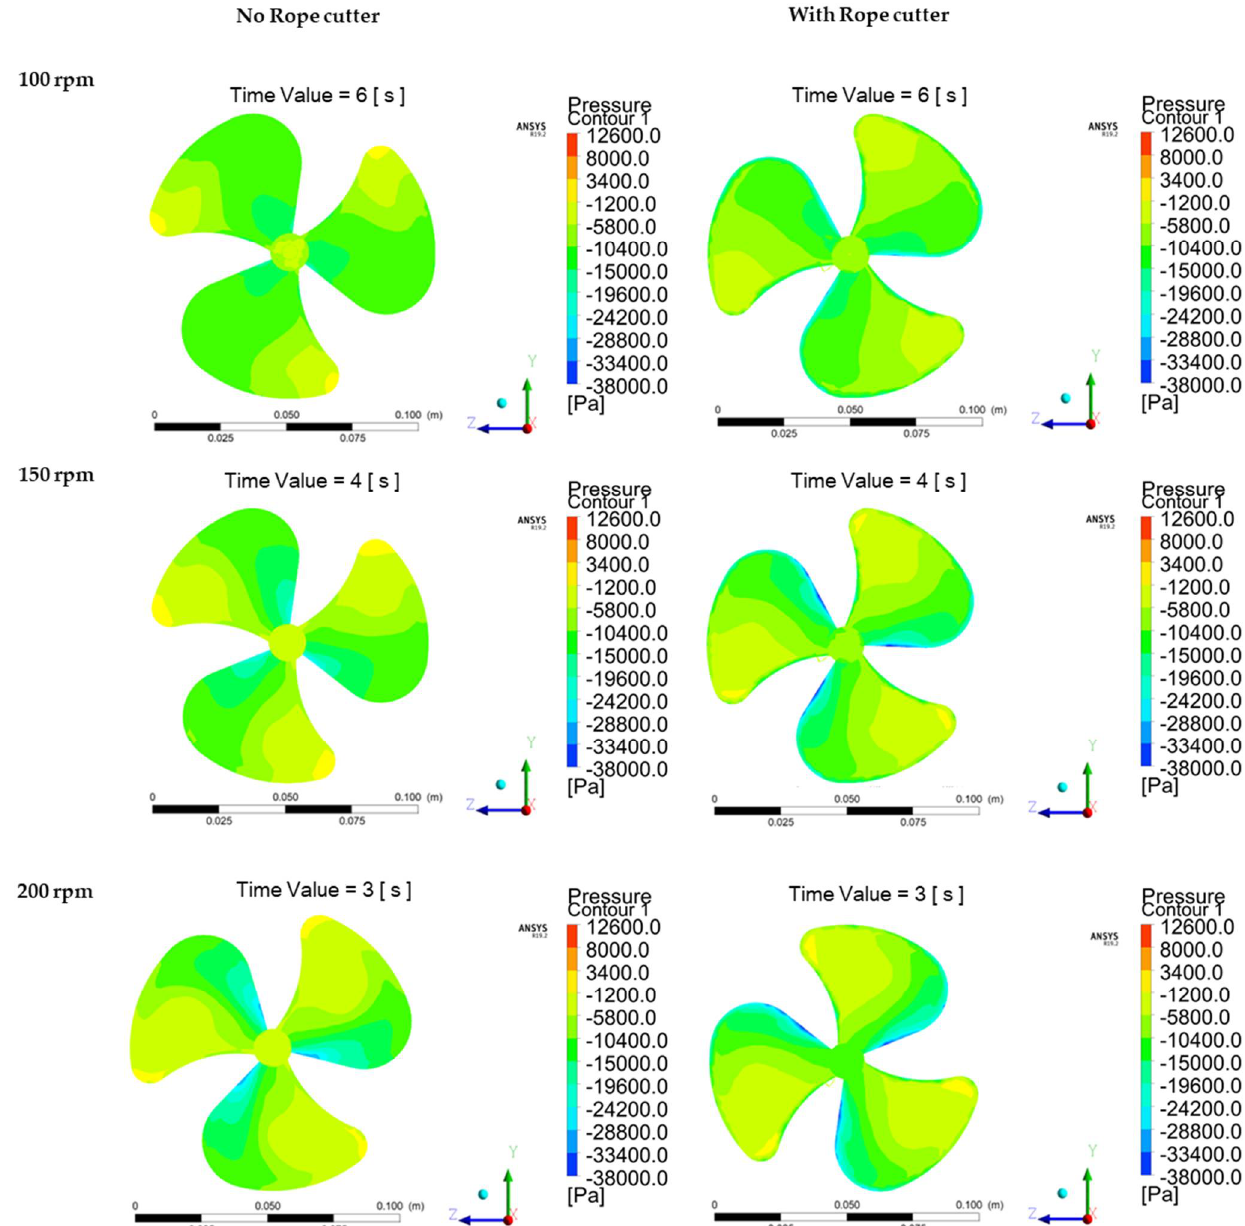
Figure 18. Pressure distribution on the propeller’s suction (back) side in [Pa]. The pressure distribution on the plane behind the propeller with a rope cutter re- duced the local regions of low pressure. The pressure was well distributed as a result of the rotating action of the rope cutter and the reduced pressure difference between the pressure side and the suction side. In addition, there was a smaller amount of vortices formed behind the propeller with a rope cutter. This is also a contributing factor to a rel- atively higher pressure distribution behind the propeller with a rope cutter installed. Low- pressure distribution is only formed near the propeller hub of the propeller with the rope cutter.